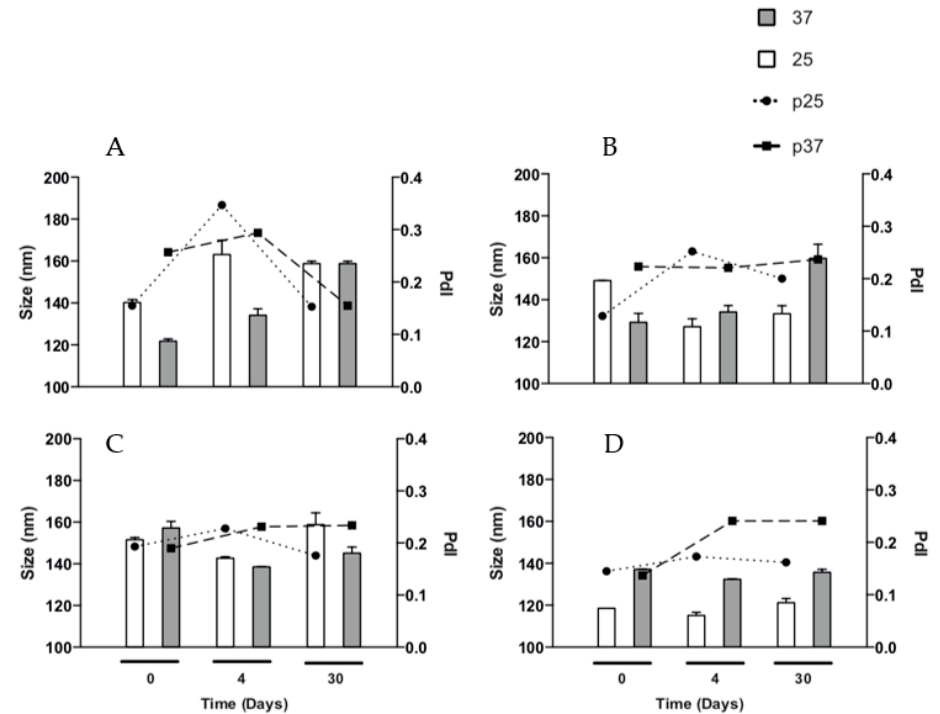
Figure 5. Stability of particle size and PDI of the formulations obtained by DLS at 25 and 37 °C for 0, 4 and 30 days. ( A ) TC 20 CR 0.5; ( B ) TC 20 CR 1.33; ( C ) TC 30 CR 0.5; and ( D ) TC 30 CR 1.33.